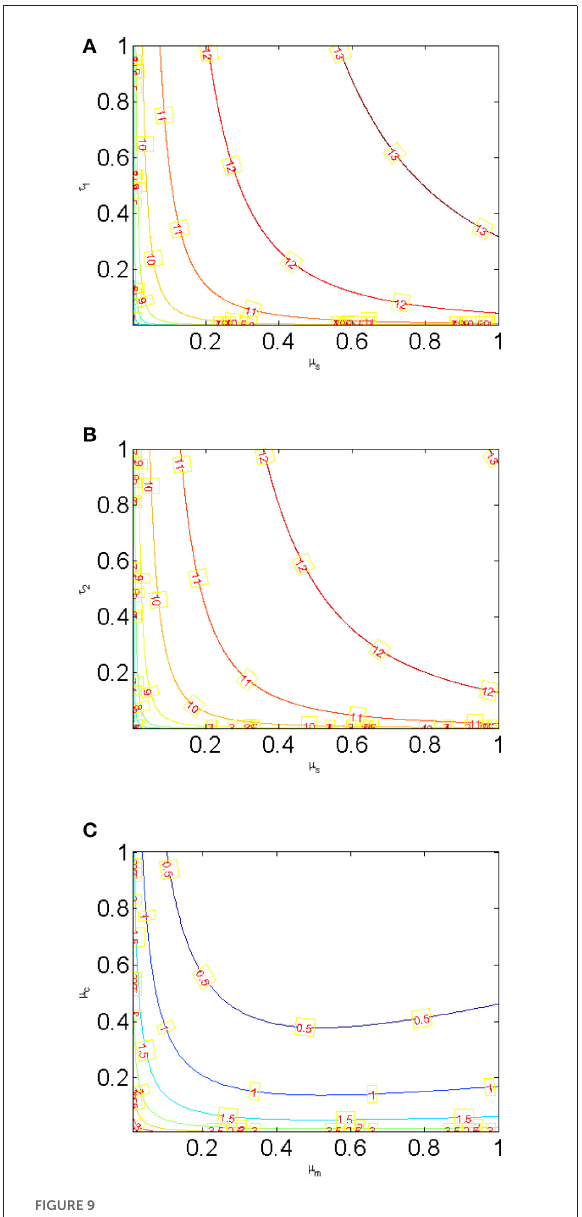
FIGURE9 Contour plots showing the effects of (A) τ 1 vs. µ s (B) τ 2 vs. µ s (C) µ c vs. µ m